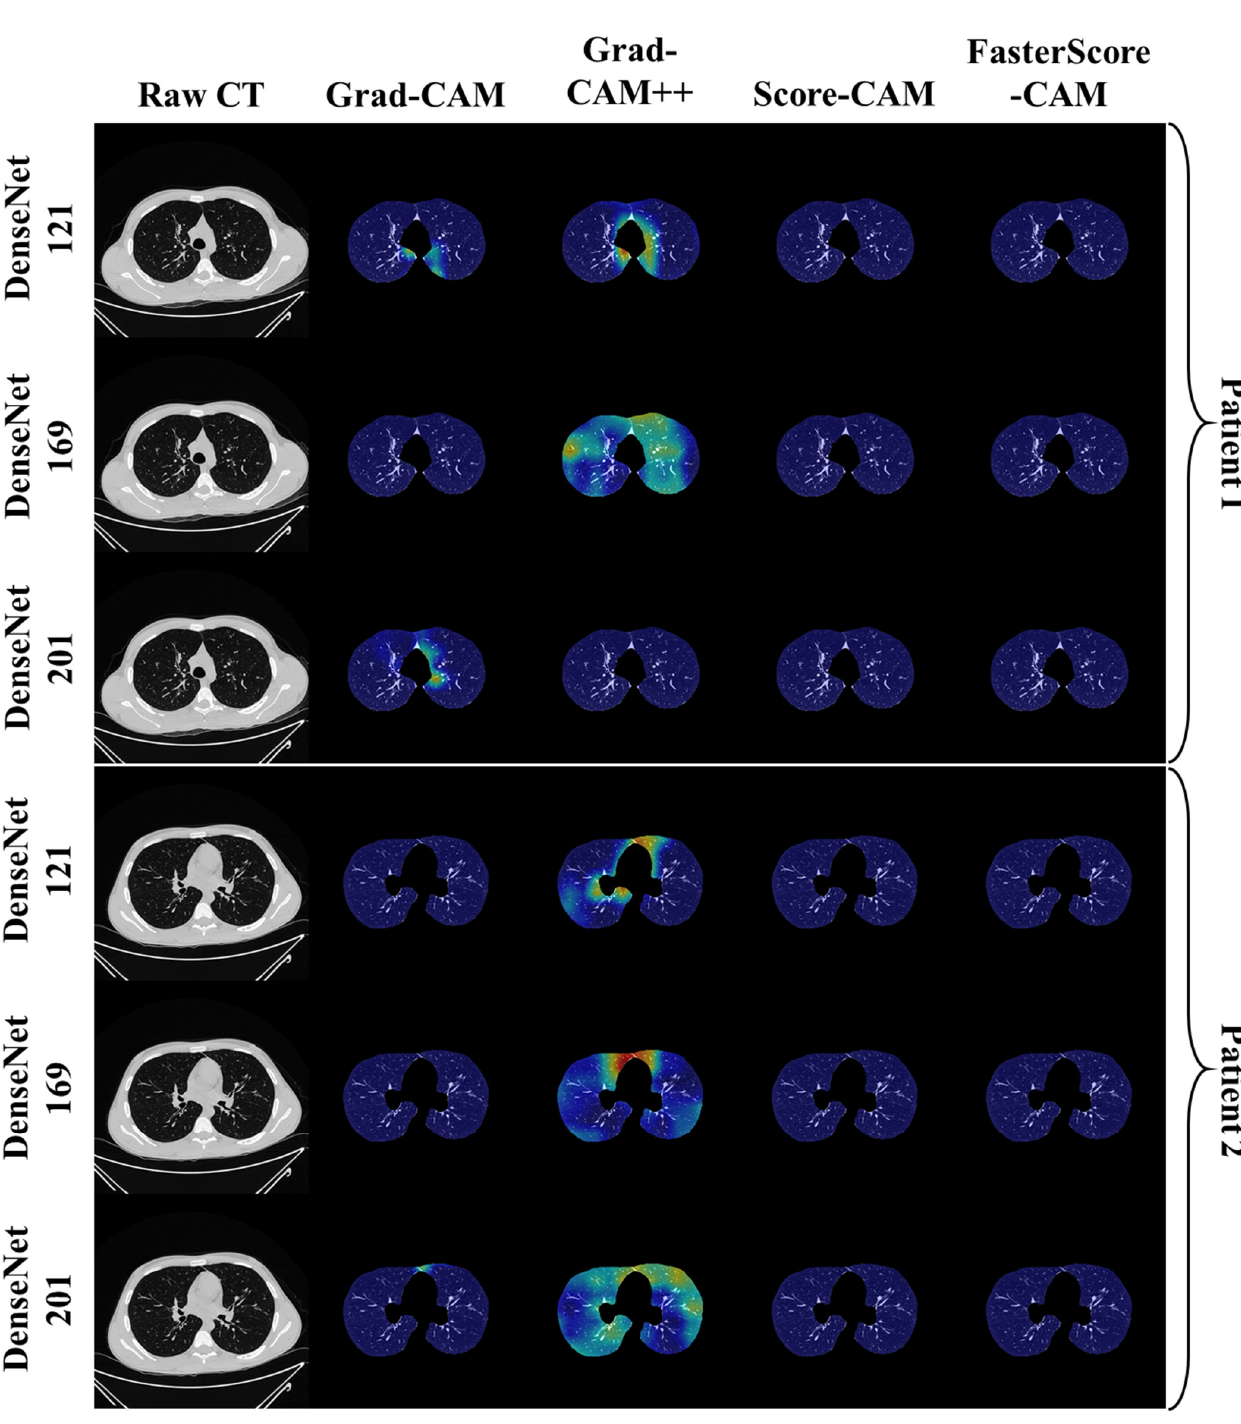
Figure 12. Heatmap using four CAM techniques using three kinds of DenseNet classifiers on control images. The top row is the CT slice for patient 1, and the bottom row is the CT slice for patient 2.